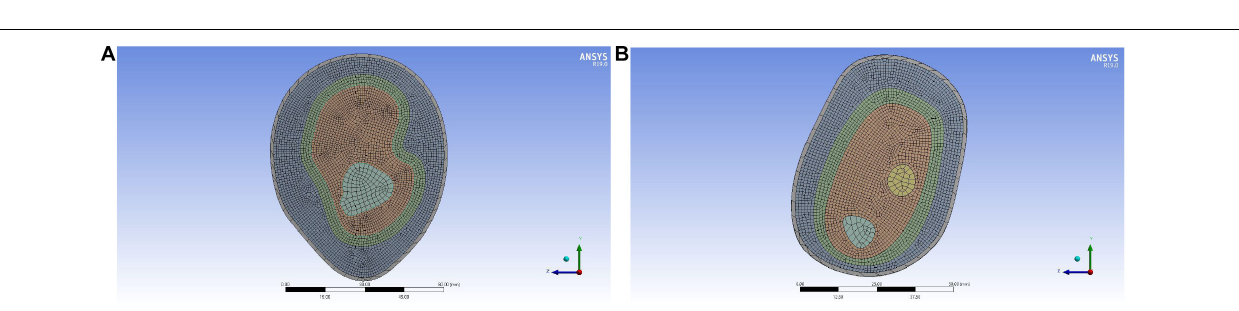
FIGURE 8 | Mesh generation of the reconstruction model of upper limb: (A) upper arm model and (B) forearm model.